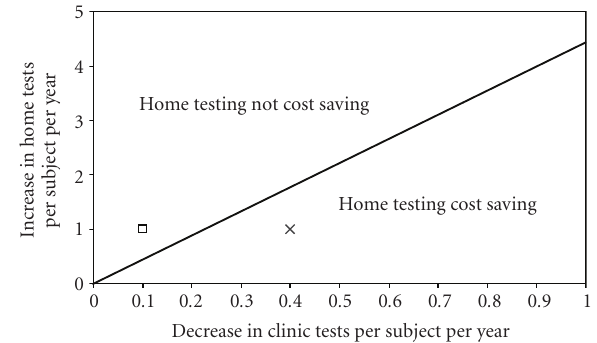
Figure 1: Two-way sensitivity analysis on changes in testing rates resulting from a home testing intervention. The line represents points where the overall costs of a home testing program or clinic- based testing are equal when gonorrhea and chlamydia detection rates are the same with either program. Points denoting changes in home and clinic testing frequency occurring due to a home testing program that fall in the area below the line (e.g., the “X”) indicate that cost savings would occur with that program. Points above the line (e.g., the open square) denote parameter values where cost sav- ings would not